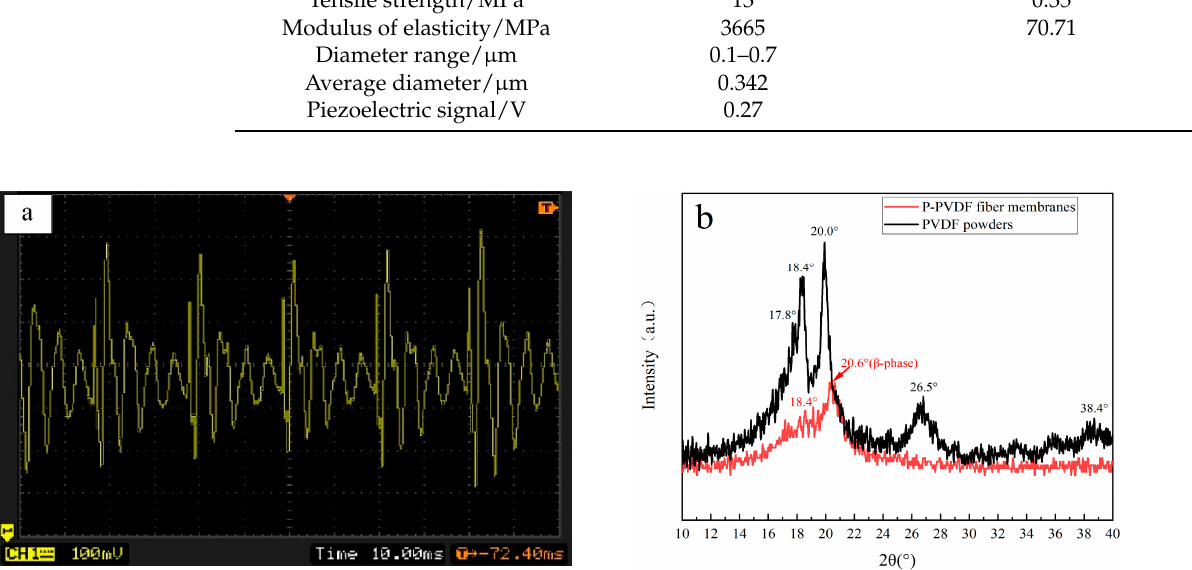
Figure 7. Piezoelectric signal image and XRD of the pure PVDF fiber membrane: ( a ) Piezoelectric signal image of the pure PVDF fiber membrane; ( b ) XRD of the pure PVDF fiber membrane.